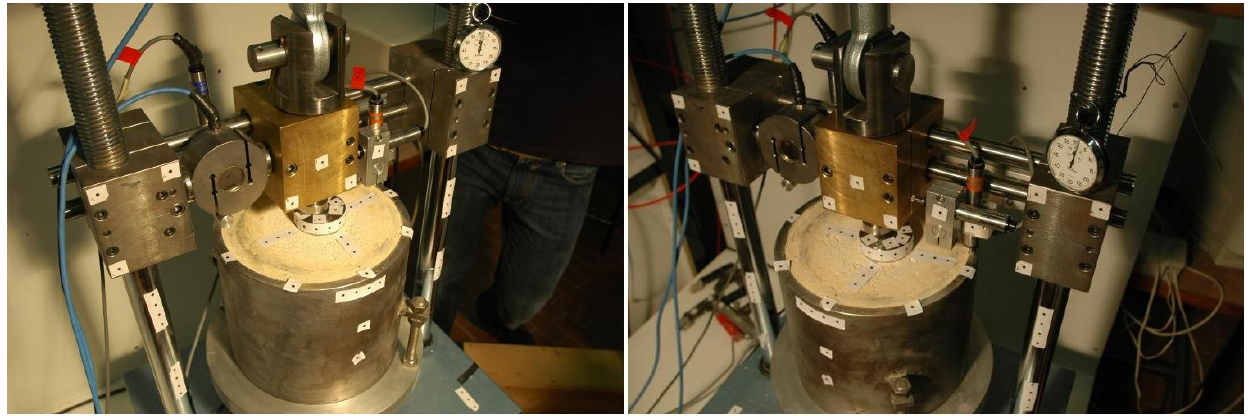
Figure 8. A target-based survey with two synchronized